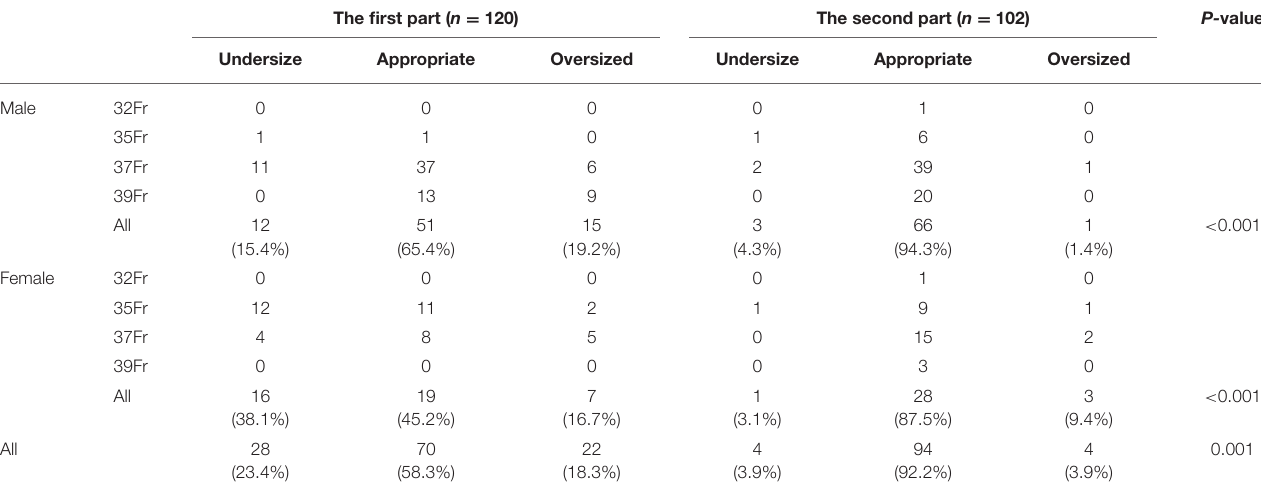
TABLE 7 | Comparison of accuracy between the first part and the second part. The first part ( n = 120) The second part ( n = 102) P- value Undersize Appropriate Oversized Undersize Appropriate